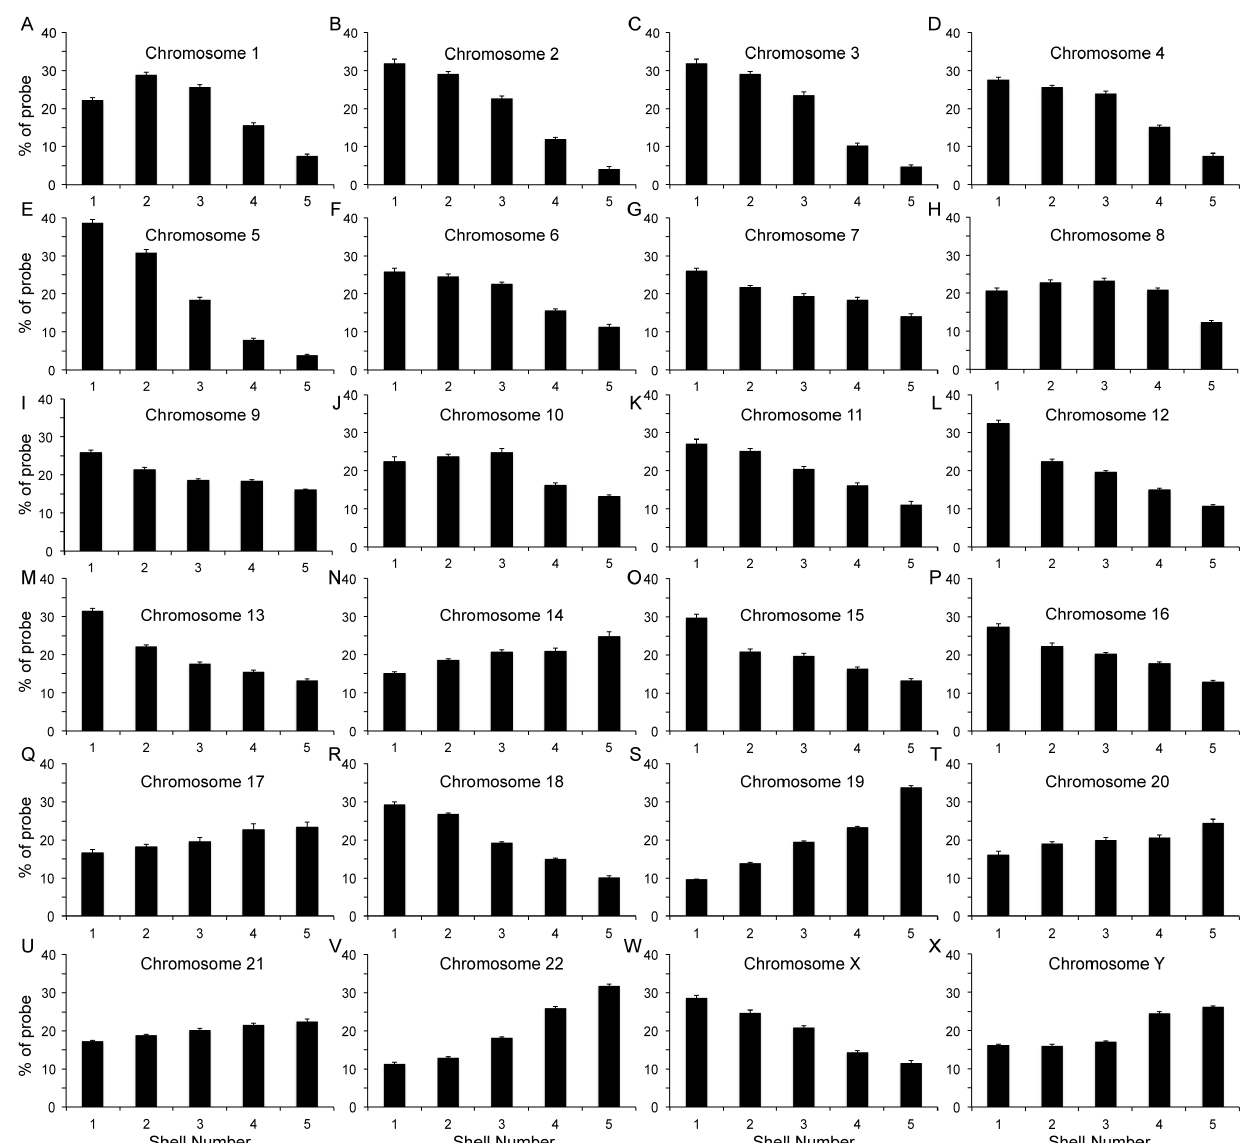
Figure 2. Histograms plotted from output of IMACULAT displaying positions of all human chromosomes in normal proliferating human dermal fibroblasts: Normal human dermal fibroblasts were subjected to standard 2D-FISH assay. At least 100 digital images were analyzed per chromosome by IMACULAT. The graphs display the % probe intensity of each human chromo-some in each of the shells (y-axis), and the shell number on the x-axis. The standard error bars representing the standard errors of mean (SEM) were plotted for each shell for each graph.